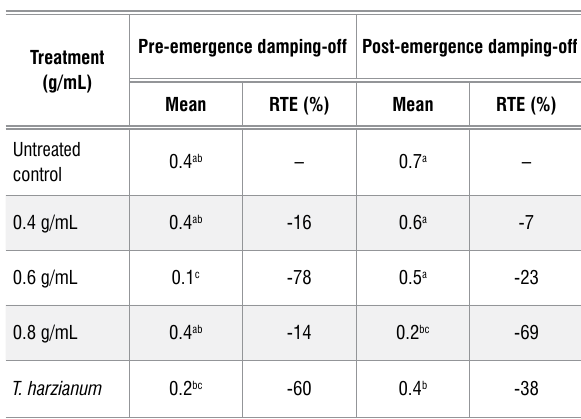
Comparing the effect of Monsonia burkeana extract and Trichoderma harzianum on pre- and post-emergence damping- off caused by Rhizoctonia solani under greenhouse conditions